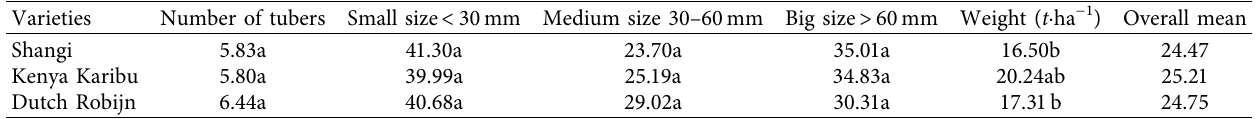
Table 13: The mean comparison for tuber yield of three potato varieties in the Molo and Egerton 2019–2020 seasons. Varieties